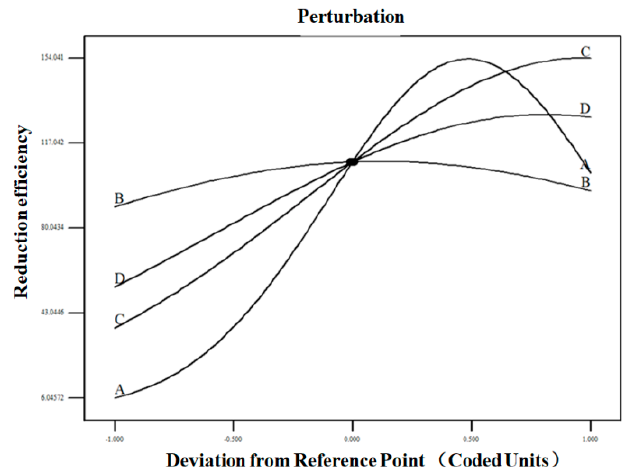
Figure 8. Perturbation plot for the reduction efficiency of vanadium in the design space: A: dosage of H 2 SO 4 , B: current intensity, C: reaction time, D: reaction temperature.